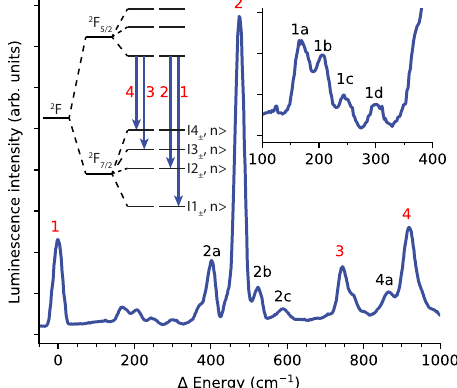
Fig. 2 Measurement and assignment of low-lying electronic states in [Yb(trensal)]. Experimental luminescence (emission) spectrum of [Yb 0.07 Lu 0.93 (trensal)] ( 1 ′ ) at 5 K 13 . Transitions are from the lowest KD of the excited 2 F 5/2 spin – orbit multiplet to the different KDs of the ground 2 F 7/2 multiplet (inset left; not to scale) and occur in the near-IR around 980 nm 13,60 . The spectrum is plotted as energy differences with respect to the zero-phonon line of the ground KD (peak 1), thus the spectrum is reversed compared to a conventional emission spectrum. The energies of the four KDs of the 2 F 7/2 multiplet, as determined from the spectrum relative to the ground KD at 0 cm − 1 (1) are: 474 cm − 1 (2), 745 cm − 1 (3) and 920 cm − 1 (4). Additional features are at 169 cm − 1 (1a), 207cm − 1